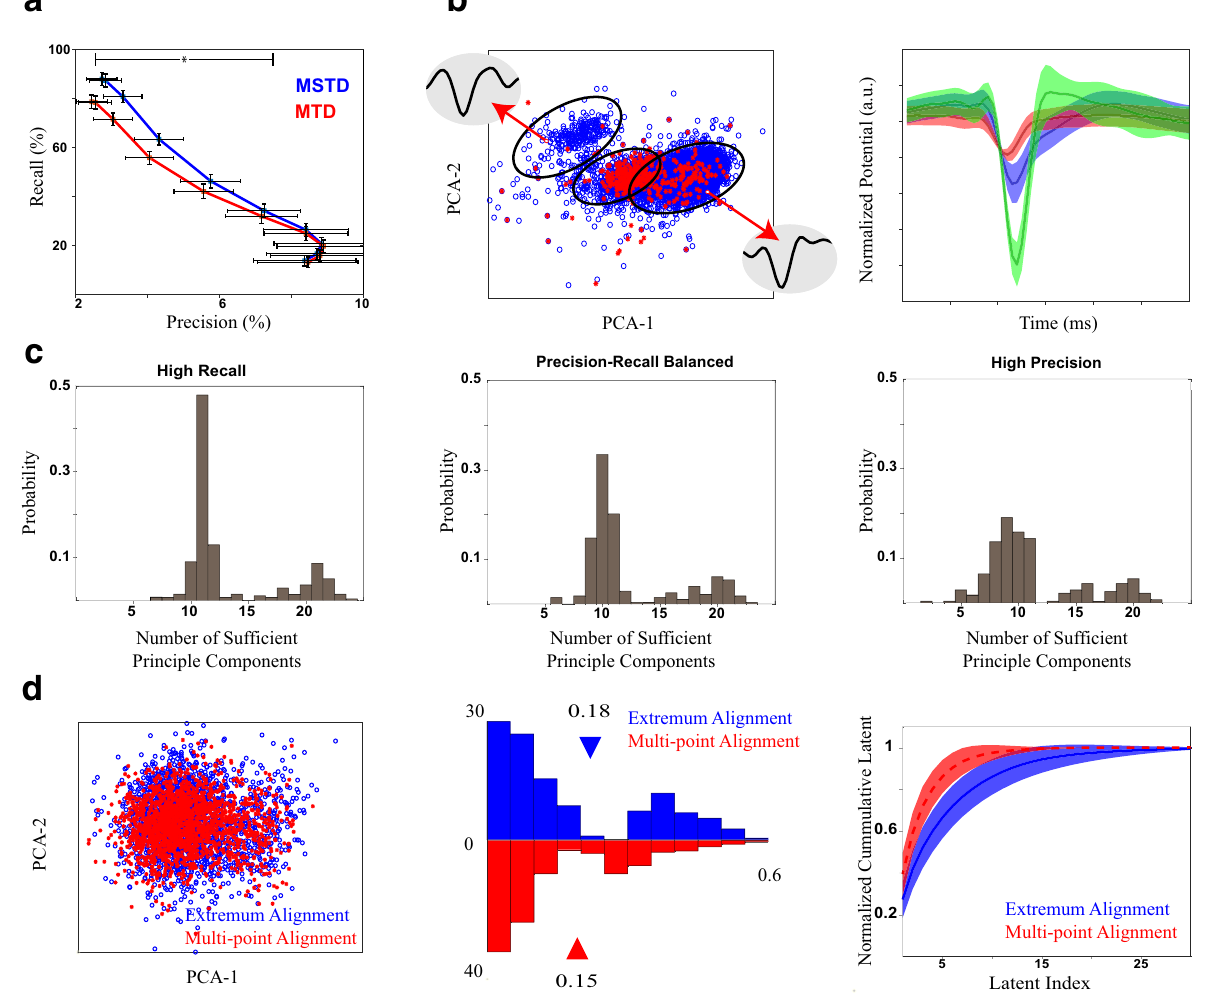
Figure 6. Comparison of MTD and MSTD using the real dataset of simultaneous intracellular and extracellular recordings of rat hippocampus 37,49 . ( a ) The precision-recall curve of the detection results. To achieve this curve, the detection threshold is varied proportional to the noise power. The standard deviation of the precision and recall are indicated using horizontal and vertical error bars, respectively. As can be seen, the precision values are small. The horizontal line with the star shows where the values of both recall and precision differ significantly. ( b ) It shows the reason for small values of precision. A recording sample is visualized using the two first principal components (left). The blue circles show the detected samples, and the red stars show the spikes detected using the ground truth. On the right, the average waveforms of neurons of this sample are illustrated. The clusters are formed using simple manual clustering. The shaded area states the standard deviation. ( c ) The histogram of the number of principal components is needed to describe the spike waveforms, n c , calculated by Eq. (5), for three situations: high recall (left), which is the point with the most recall value in ( a ), precision- recall balanced (middle), which is the point in the middle of high recall and high precision points in ( a ), and high precision (right), which is the point with the most precision value in ( a ). ( d ) The effect of alignment on the cluster compactness. A sample of ground truth spikes of two recordings is visualized using the first two principal components (left). The blue circles and red stars show data for two alignment methods. One is the alignment based on waveform extremum (extremum alignment), and the other is the proposed multi-point alignment. The histogram of within distance of ground truth spikes for extremum alignment and the proposed multi-point alignment (middle), and normalized cumulative latent [the left side of Eq. (5)] is shown for both alignment methods (right). The shaded area is the standard